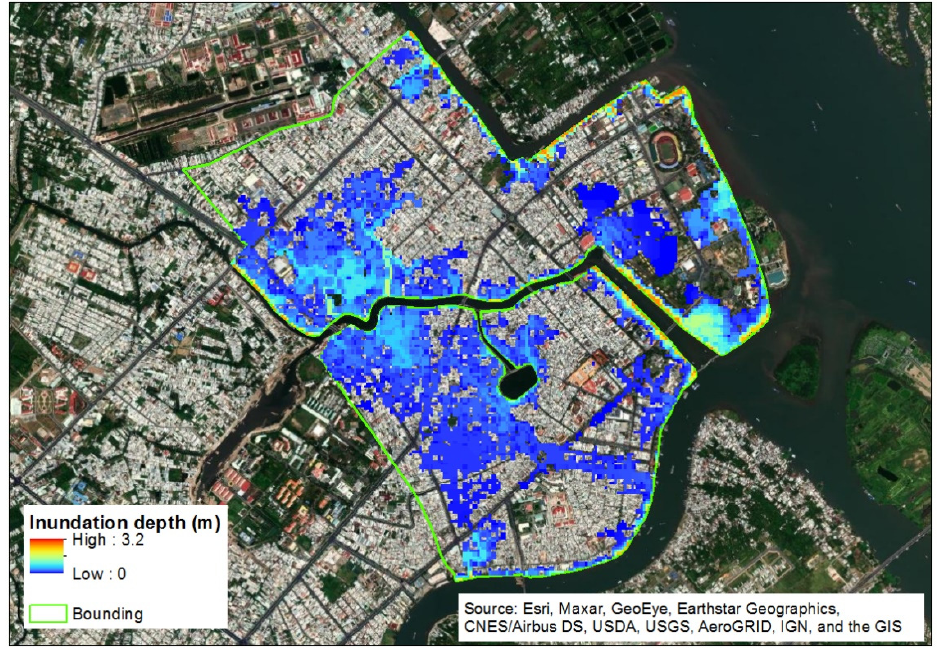
Figure 5. Inundation map corresponding to 100-year return period water level at Can Tho in the year 2050 under RCP 8.5. 2050 under RCP